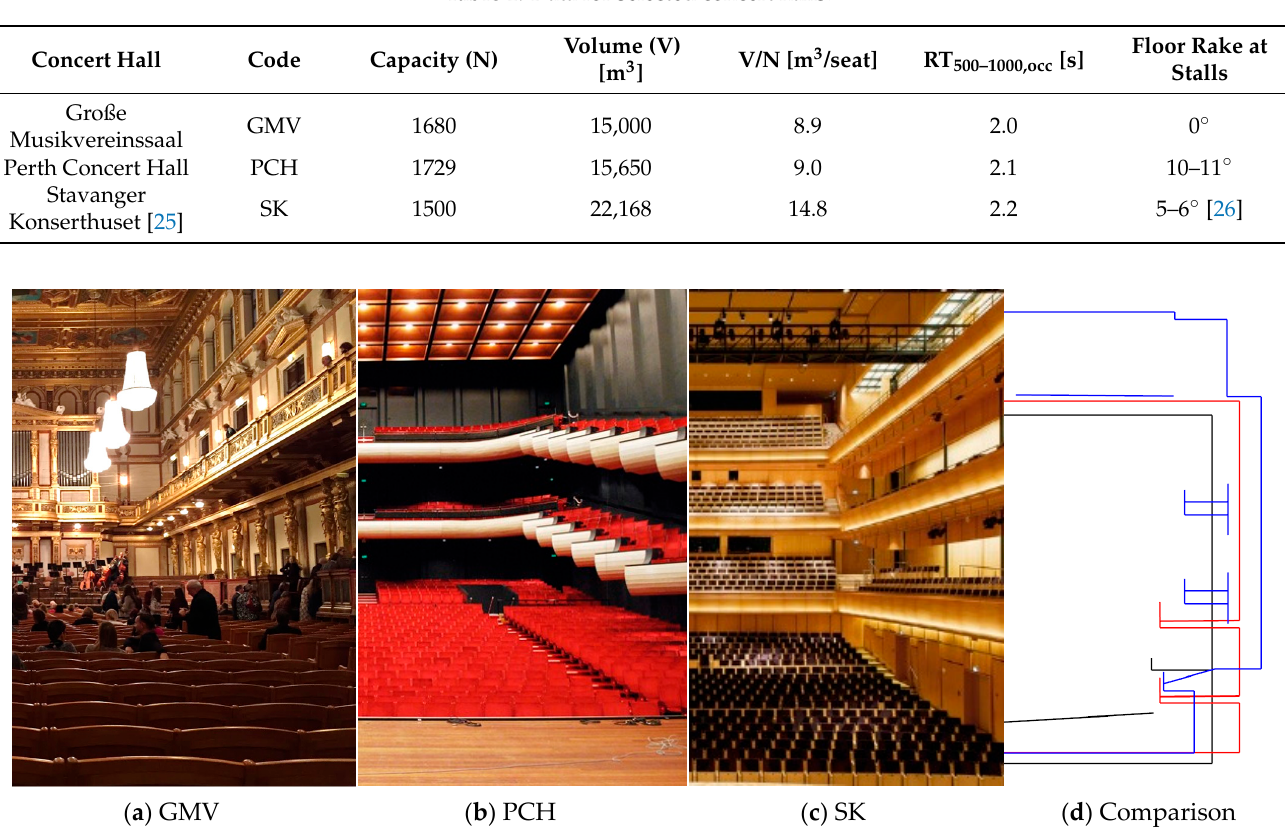
Figure 2. ( a ) Große Musikvereinssaal (photo: J.O. Garc í a); ( b ) Perth Concert Hall (photo: Marshall Day Acoustics); ( c ) Stavanger Konserthuset (photo: https://sso.no/en/seating-plan-fartein-valen/ accessed on 24 August 2021); ( d ) Com- parison of concert hall’s cross-section: ( Black ) Große Musikvereinssaal, ( Red ) Perth Concert Hall, ( Blue ) Stavanger Kon- serthuset